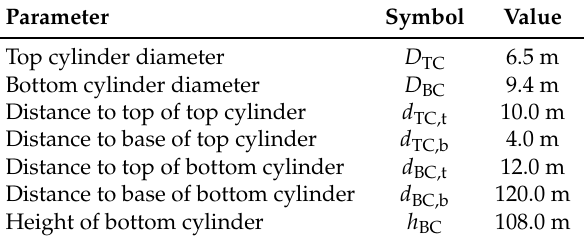
Table 1. Geometrical parameters of the OC3 spar-buoy [8].